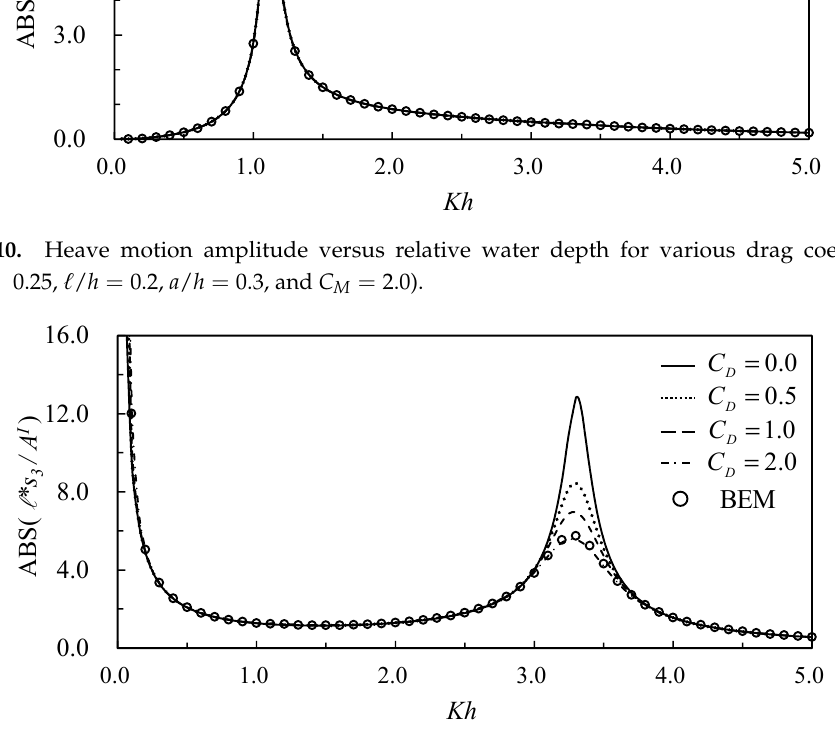
Figure11. Pitchmotionamplitudeversusrelativewaterdepthforvariousdragcoe ffi cients( d 1 / h = 0.25, Figure 11. Pitch motion amplitude versus relative water depth for various drag coefficients ( (cid:96) / h = 0.2, a / h = 0.3, and C 25.0 = M